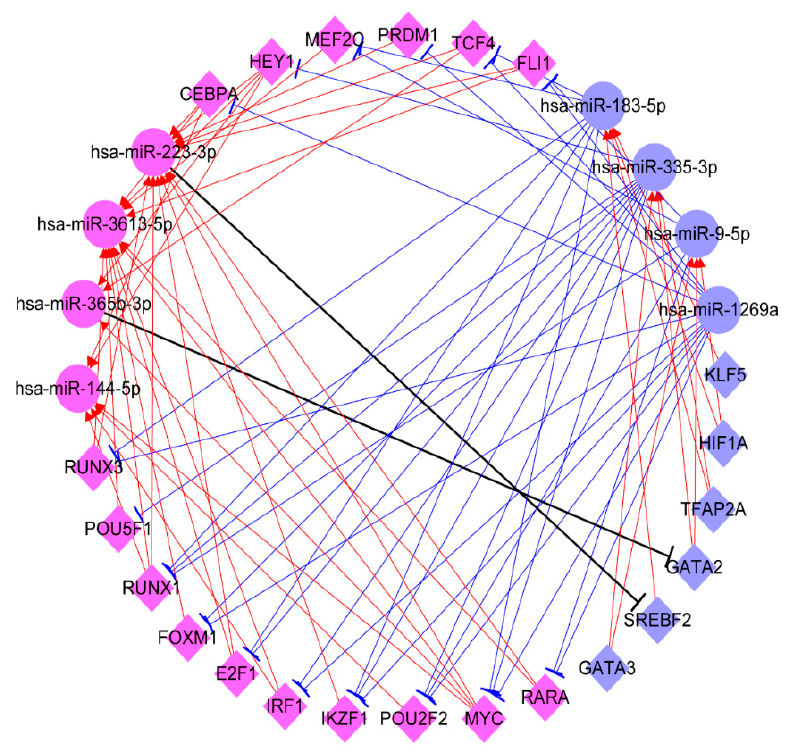
Figure 7. The interplay network between twenty-two transcription factors and eight miRNAs. The circle represents the miRNA and the diamond represents the transcription factor. The blue represents a down-regulation expression and the purple represents an up-regulation expression. The sharp arrow represents activation and the flat arrow represents inhibition.